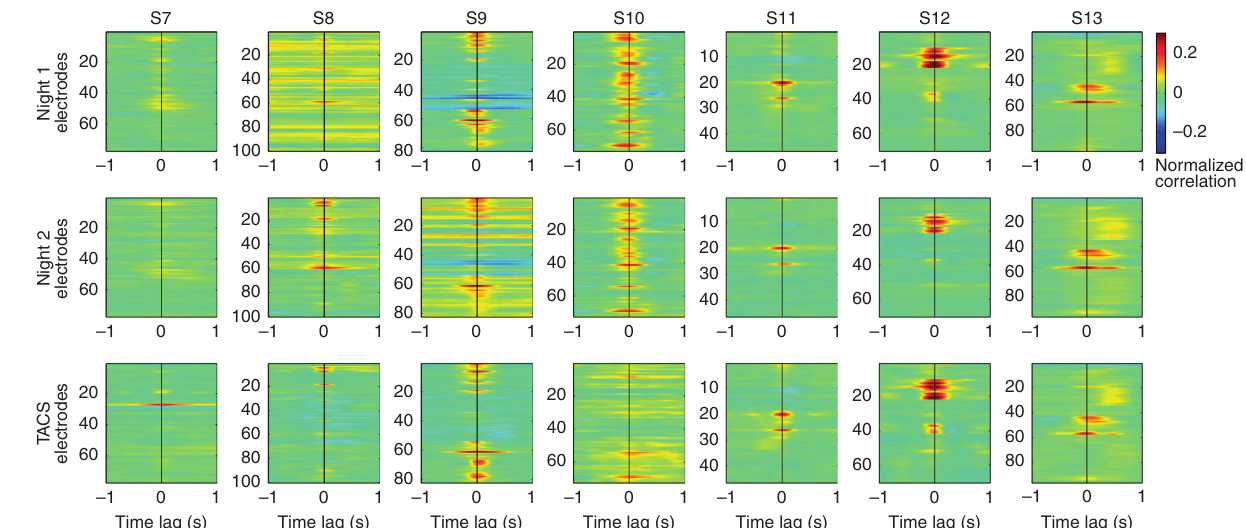
Fig. 5 Cross-correlation between the amplitudes of spindle and gamma oscillations. Panel shows cross correlation for all electrodes for seven subjects (S7 – S13) during two nights of sleep without stimulation and one with tACS. False color indicates correlation values. Vertical axis indicates electrode number and horizontal axis indicates time lag between the two rhythms. The peak at zero time-lag indicates that spindle and gamma occur at the same time, negative lag indicates that spindle activity precedes gamma